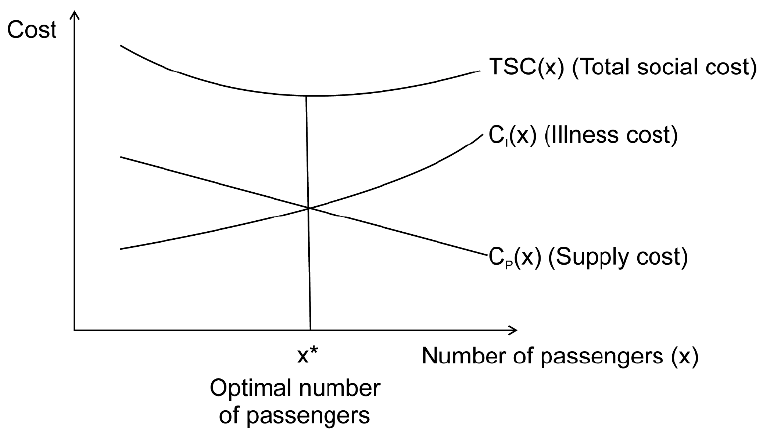
Figure 1. Optimal number of passengers (x*) to minimize the total social cost.